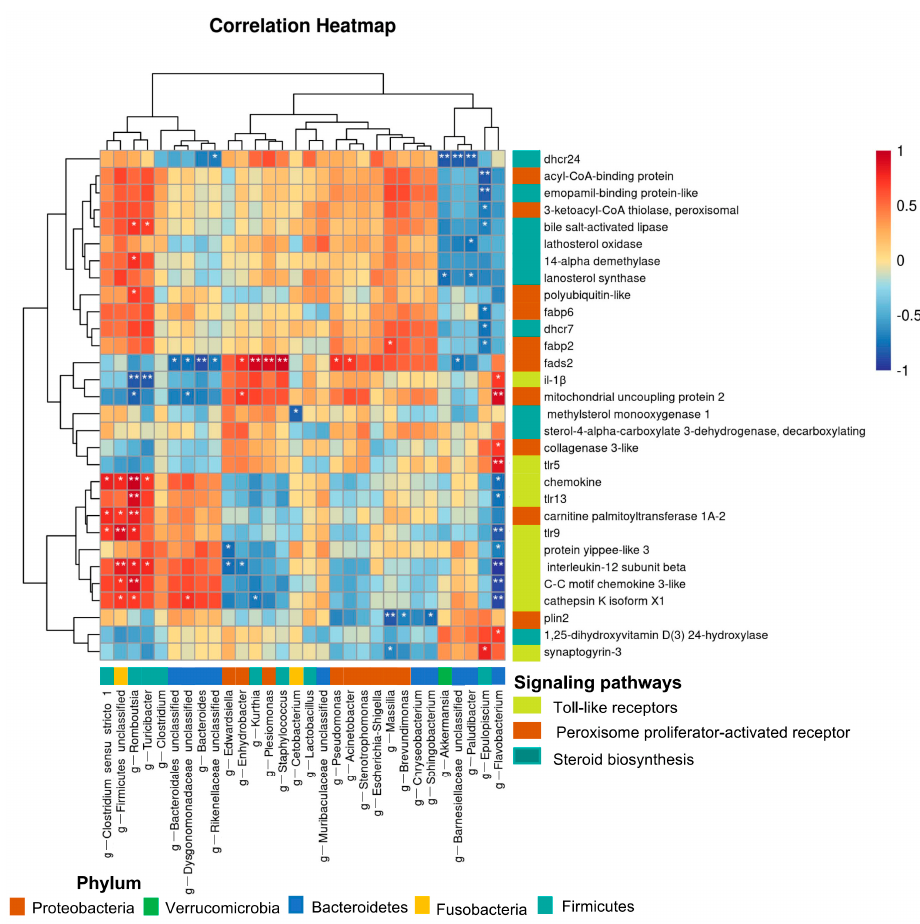
Figure 9. Significant correlation between intestinal bacteria at genus level and differentially expressed genes of toll-like receptors, peroxisome proliferator-activated receptor, and steroid biosynthesis signaling pathways ( *, p < 0.05; **, p < 0.01).